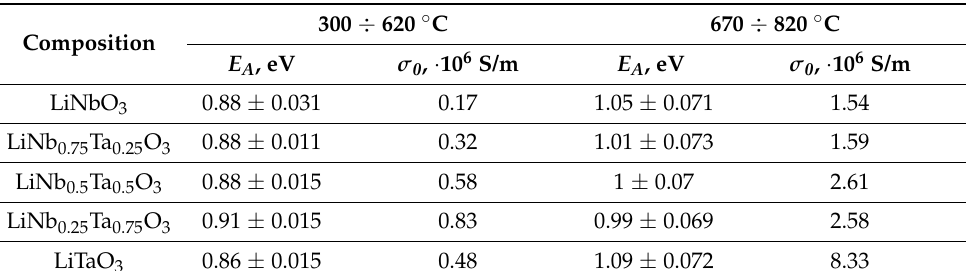
Table 4. Activation energies E A and pre-exponential coefficients σ 0 for conductivity of LiNb 1 − x Ta x O 3 pressed pellets at different temperatures.